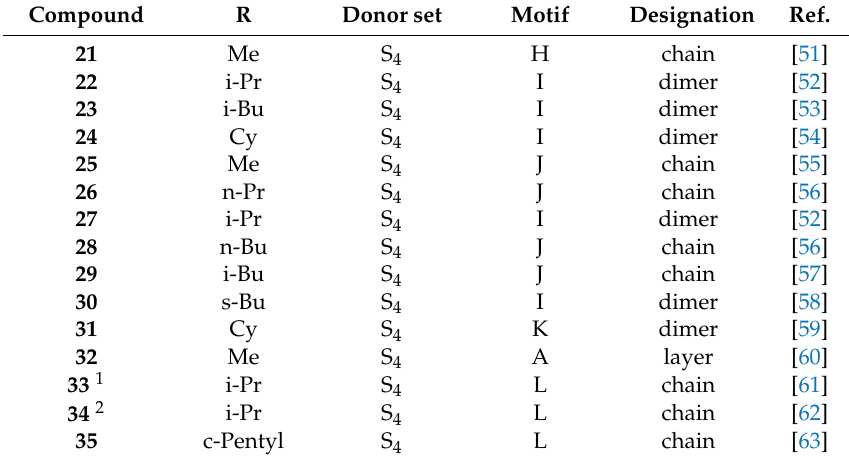
Table 2. Summary of the general features of M[S 2 P(OR) 2 ], M = zinc ( 21 – 24 ), cadmium ( 25 – 31 ), and mercury ( 32 – 35 ),